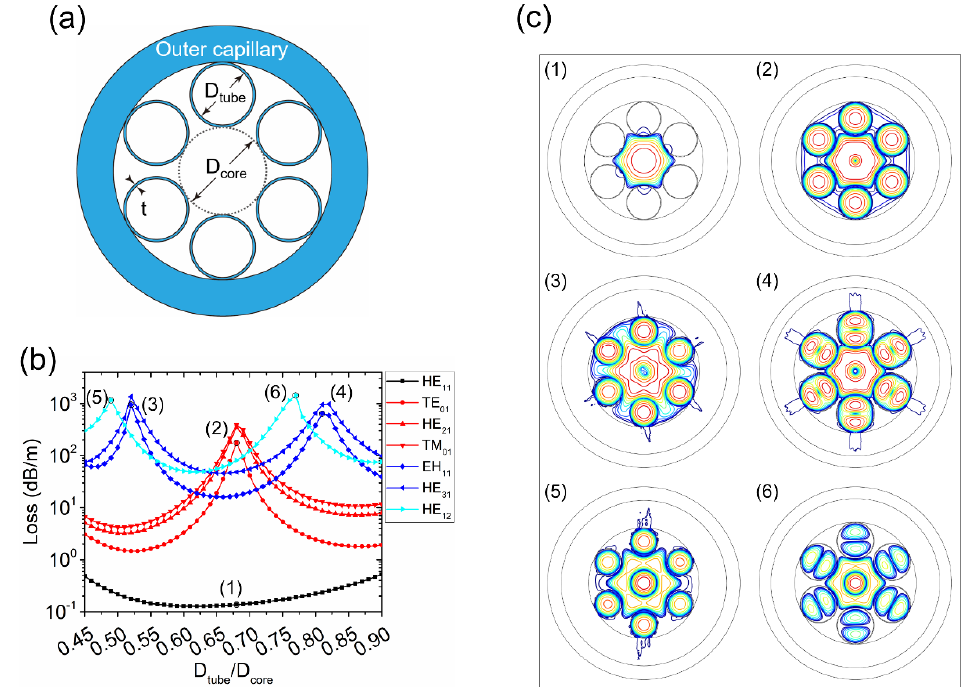
Figure 1. ( a ) Geometry of the six-tube negative curvature hollow-core fiber (NC-HCF) structure. ( b ) Simulated losses of the fundamental HE 11 mode and six higher-order modes (HOMs) (TE 01 , HE 21 , TM 01 , EH 11 , HE 31 , and HE 12 ) as a function of D tube / D core . ( c ) Three decibel (3-dB) contour lines of mode patterns: (1) LP 01 modes at D tube / D core = 0.68, point (1) in ( b ); (2) LP 11 modes at D tube / D core = 0.68, point